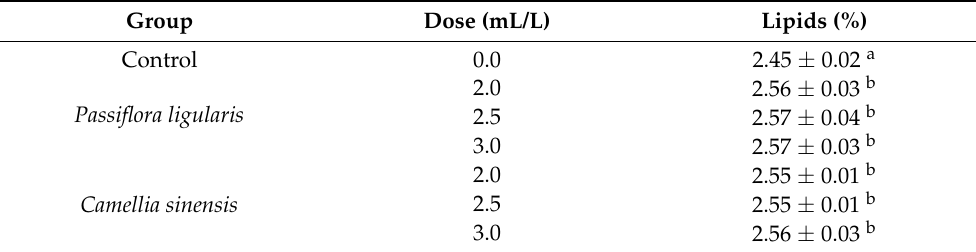
Table 2. Effect on feces lipid percentages after supplementation with polyphenol extracts at different doses.